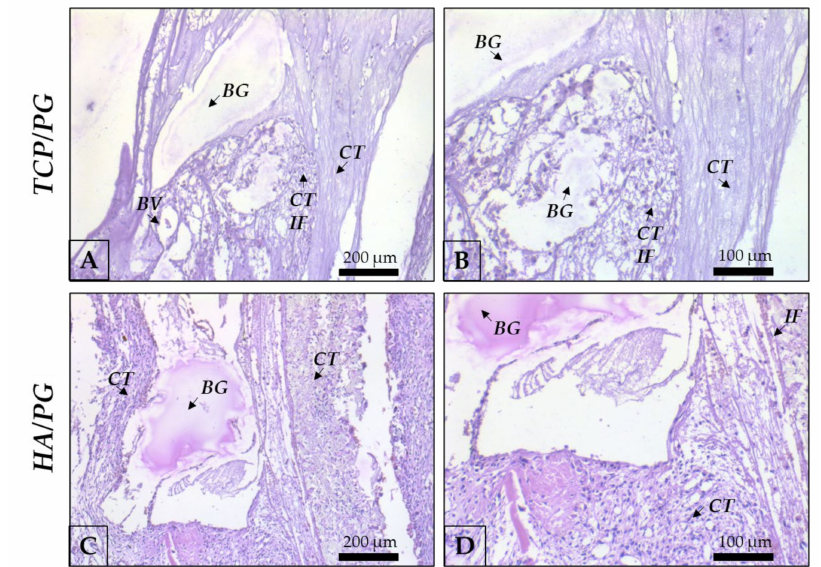
Figure 5. Representative photomicrographs of TCP/PG and HA/PG at 7 days histological analysis. ( A ): TCP/PG 20 × magnification; ( B ): TCP/PG 40 × magnification; ( C ): HA/PG 20 × magnification; ( D ): HA/PG 40 × magnification. Staining: Hematoxylin and eosin. Legend: BG: bone graft; CT: connective tissue; BV: blood vessel; IF: inflammatory infiltrate. Scale bar: 200 µ m (10 × magnification) and, 100 µ m (20 ×